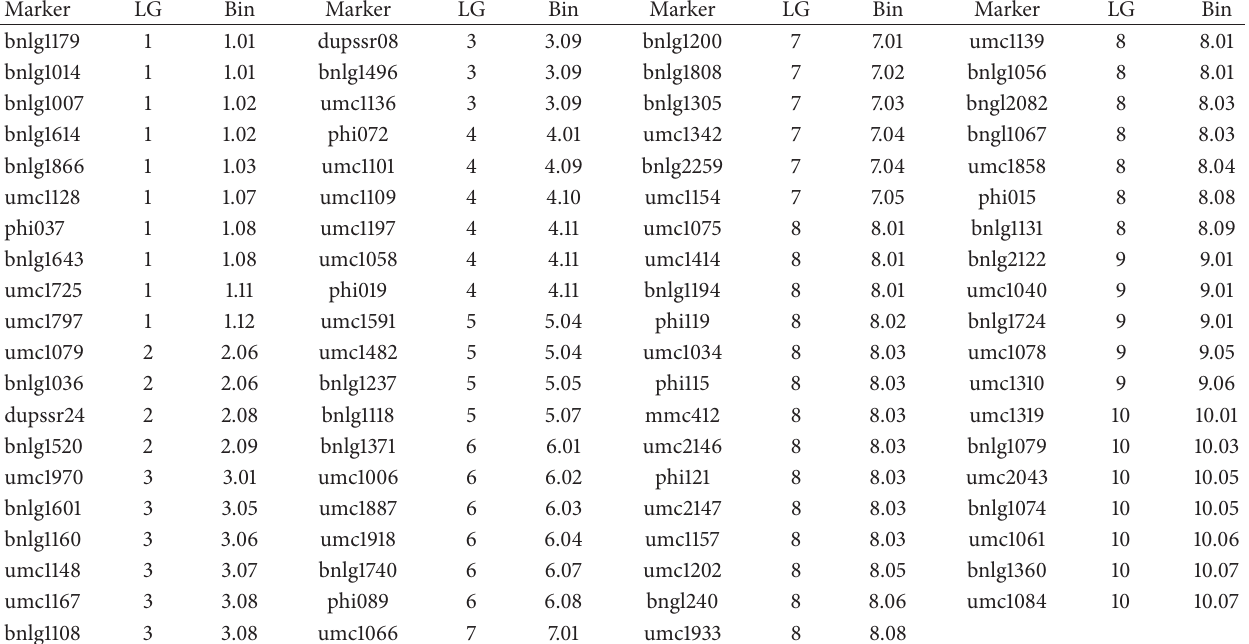
Table 1: Distribution of the 79 microsatellite markers within the 10 linkage groups (LG) of